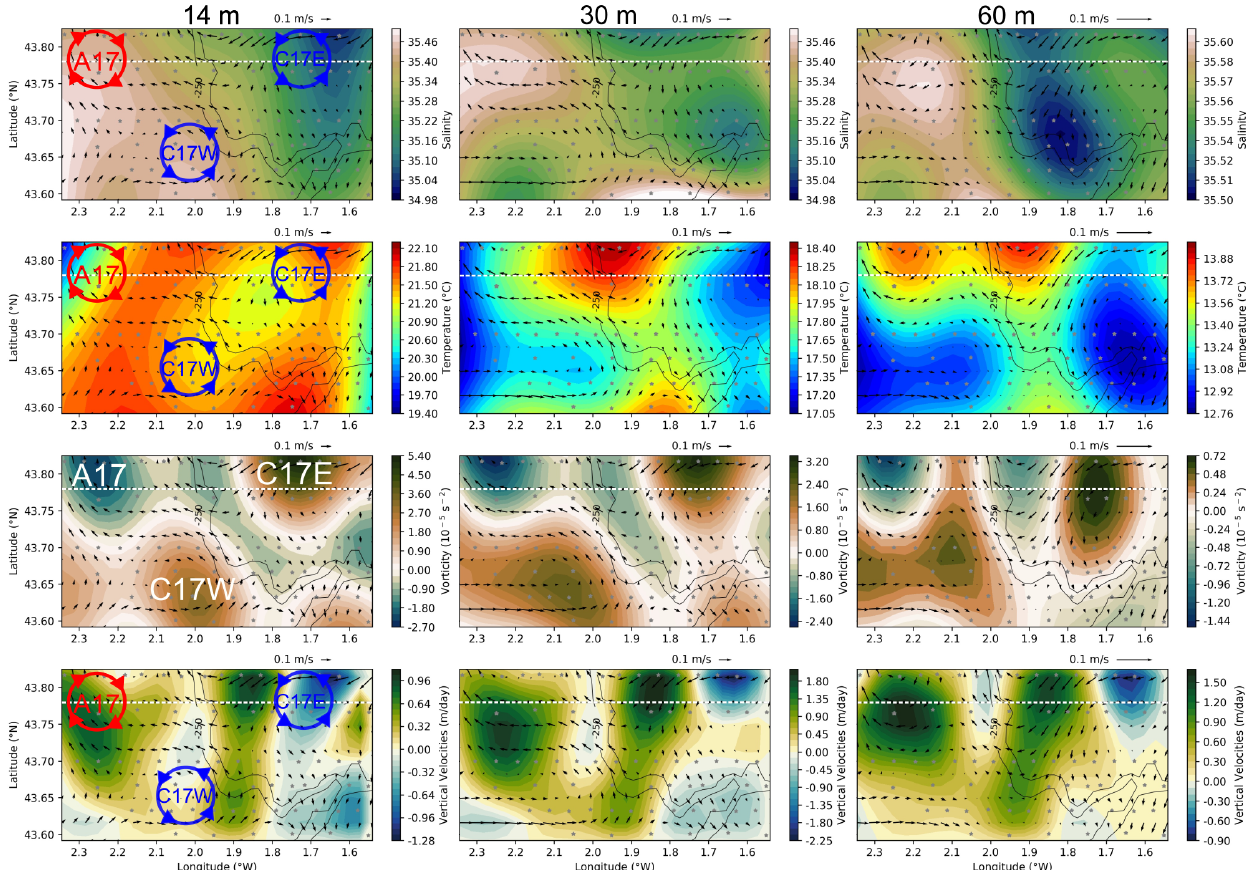
Figure 4. Synoptic plots for the hydrographic and hydrodynamical conditions for the period (2 to 4 August 2017). From top to bottom the following variables are shown: salinity, temperature, vorticity, and vertical velocity fields, at 14, 30, and 60m (left to right). Black arrows correspond to the geostrophic velocities, and black contours represent the 200 and 250m isobaths. The dashed white line corresponds to the cross section at 43.77 ◦ N shown in Figs. 5 and 7. Negative vorticity values represents anticyclonic circulation, while positive values represent cyclonic circulation. Negative (positive) vertical velocity values represent downwelling (upwelling). The red (blue) circles drawn in the left column represent the approximate location of A17 (C17W and C17E). The scale range for each of the variables is different for each